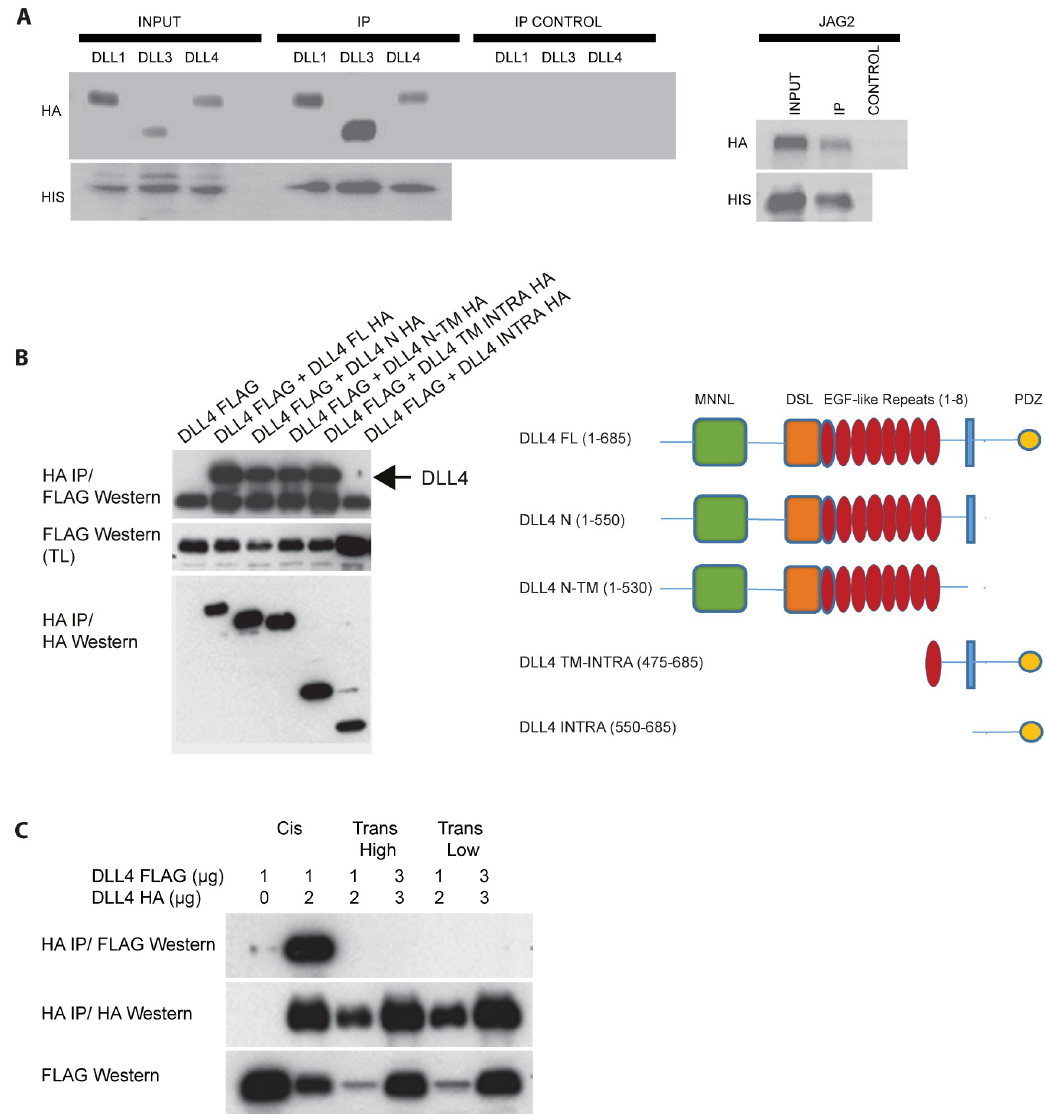
Fig 1. Notch ligand homo-oligomerization. (A) HIS epitope-tagged Notch ligands were purified from tissue-culture cells and incubated with the indicated HA-epitope tagged proteins produced by in vitro translation. Ligand-ligand interactions were determined by Western blotting using the shown antibodies. (B) Left panel: The indicated constructs were transfected into tissue- culture cells. Complexes were resolved by immunoprecipitation and visualized with the shown antibodies. Right panel: schematic representation of the constructs used in the study. (C) The indicated constructs were transfected into tissue-culture cells in one of three ways: cis- ligands were co-expressed in the same cells sparsely plated to exclude trans interactions; trans (high)- differently tagged ligands were expressed individually in cells, which were subsequently mixed in confluent cell monolayers to enable trans interactions; trans (low)- as for trans (high) but cells were plated at low cell density. Complexes were resolved by immunoprecipitation and visualized using the shown